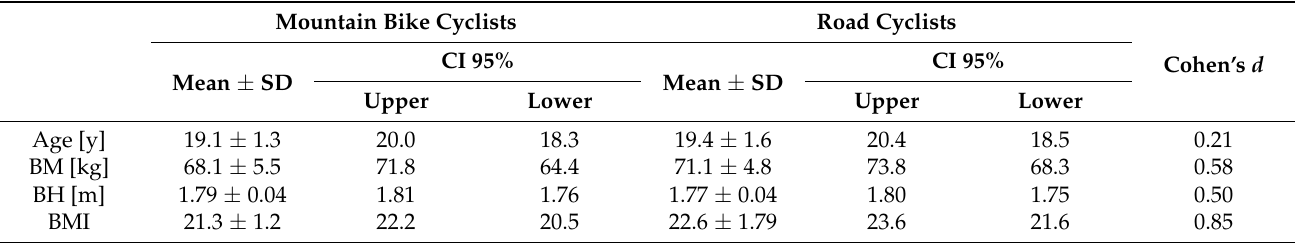
Table 1. Anthropometric characteristics of the mountain bike and road cyclists. Mountain Bike Cyclists Road Cyclists CI 95% CI 95% Cohen’s d Mean ± SD Mean ± SD Upper Lower Upper Lower Age